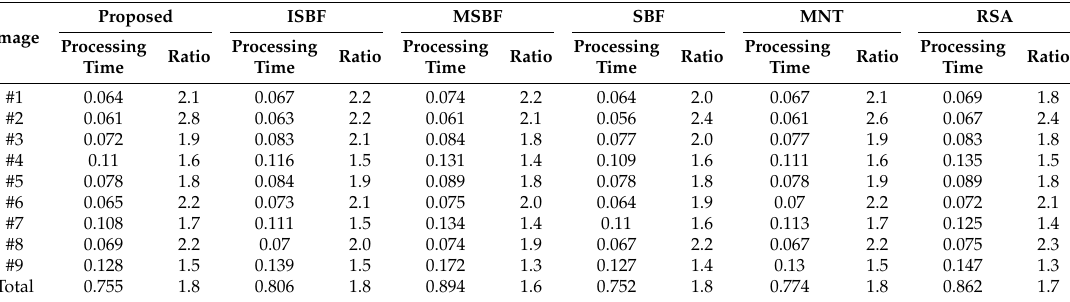
Table 12. Computational time traced